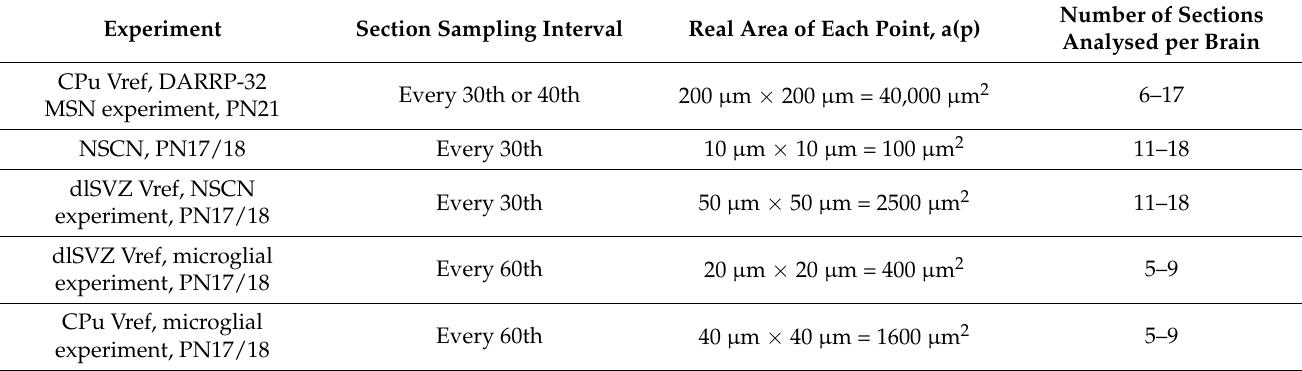
Table 1. Stereological parameters used to measure the Vref of each brain region of interest. Experiment Section Sampling Interval Real Area of Each Point, a(p)